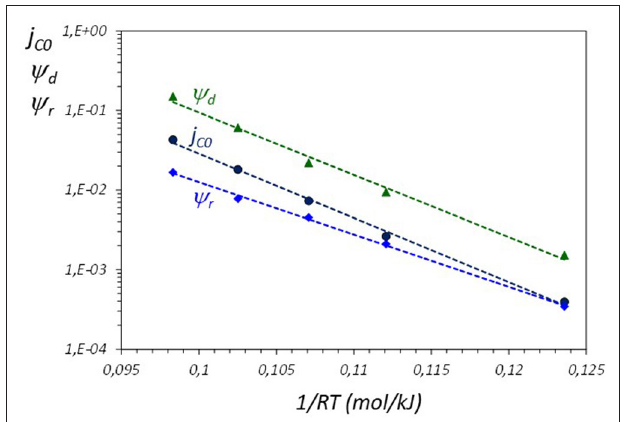
FIGURE 11 | Influence of temperature and methane concentration on the kinetic parameter n of Equation